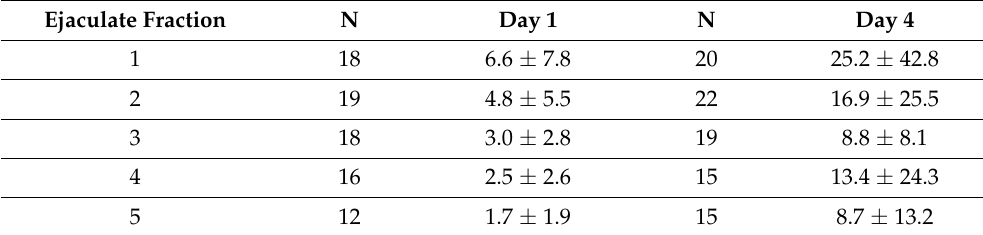
Table 4. Mean ( ± SD) fosfomycin concentrations ( µ g/mL) measured in seminal plasma on Days 1 and 4 after one and two consecutive doses of fosfomycin trometamol (N = 22). Ejaculate Fraction N Day 1 N Day 4